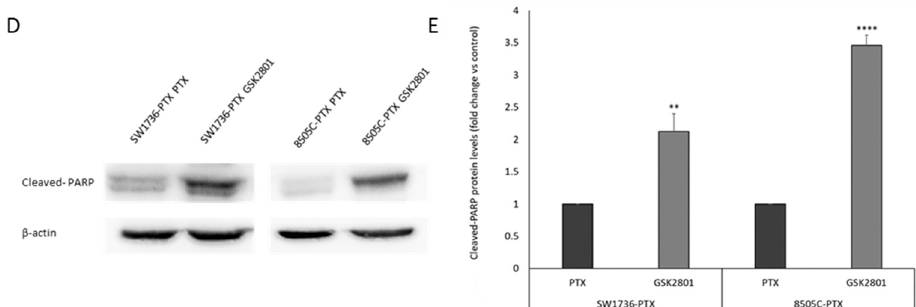
Figure 2. Effect of GSK2801 on cell viability. ( A ) Both 8505C and SW1736 cells were treated with GSK2801 at different doses (rising from 0.25 μ M to 40 μ M) or vehicle (DMSO) for 72 h and cell viability was assessed by MTT assay. ( B ) Both 8505C and SW1736 paclitaxel ‐ resistant (8505C ‐ PTX and SW1736 ‐ PTX) cells were treated with GSK2801 at different doses (rising from 0.25 μ M to 40 μ M) or vehicle (DMSO) for 72 h and cell viability was assessed by MTT assay. ( C ) Both 8505C ‐ PTX and SW1736 ‐ PTX were treated with paclitaxel alone (PTX), GSK2801 alone, or in different combination with paclitaxel for 72 h. Cell viability was evaluated by MTT assay. Each point represents the mean of six measurements. n = 6. p values refer to the comparison of GSK2801 alone or in combination. ( D , E ) Cleaved ‐ PARP protein levels were evaluated as apoptosis marker by Western blot assay in SW1736 ‐ PTX and 8505C ‐ PTX cells treated with vehicle (PTX) or paclitaxel 200 nm and GSK2801 20 μ M (GSK2801). For each cell line, the results were normalized against β‐ actin levels and expressed in arbitrary unit. Data are representative of 3 independent experiments and results are shown as mean ± SD. * p < 0.05 ** p < 0.01, *** p < 0.001, **** p < 0.0001.